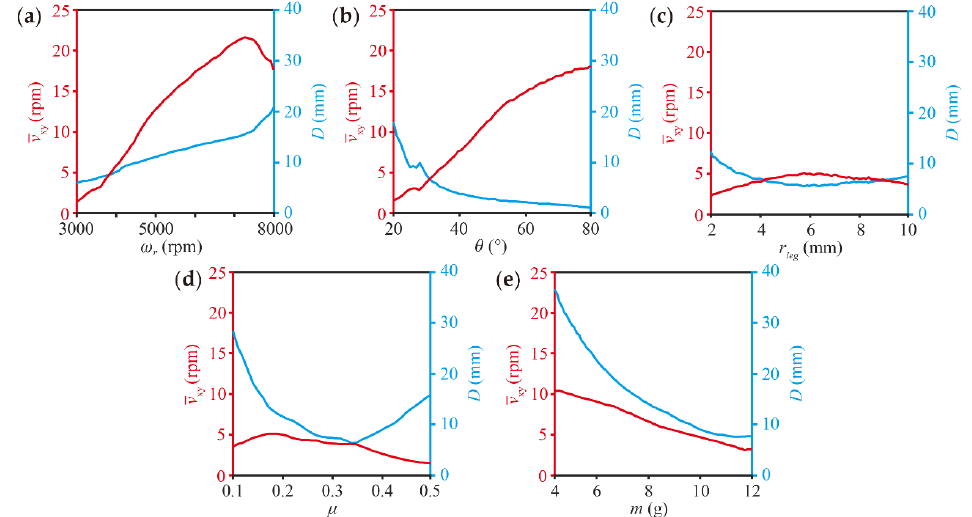
Figure 5. Effects of different parameters on robot motion performance, including ( a ) the motor speed, ( b ) the initial inclination angle, ( c ) the horizontal distance between the legs, ( d ) the coefficient of friction, and ( e ) robot mass.